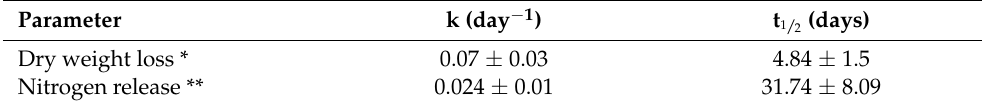
Table 2. Decomposition dynamic and N release of Ulva ohnoi .